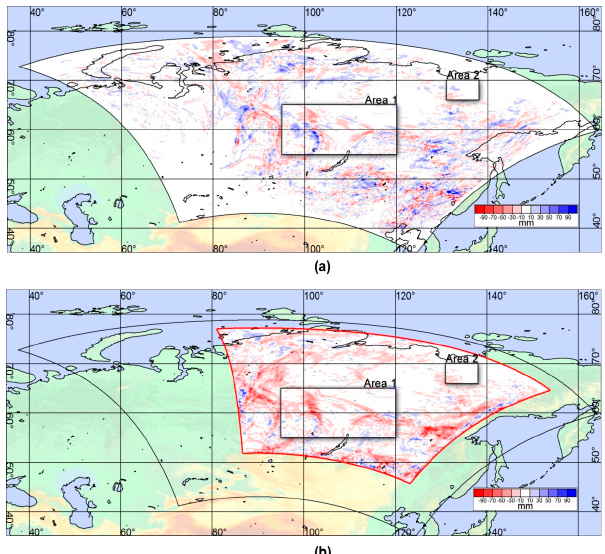
Figure 6. Spatial distribution of accumulated precipitation difference (mm) from 1–14 August 2019: ( a ) between forest fire experiment 1 (without ART) and control experiment, ( b ) between forest fire experiment 3 (with ART) and control experiment.